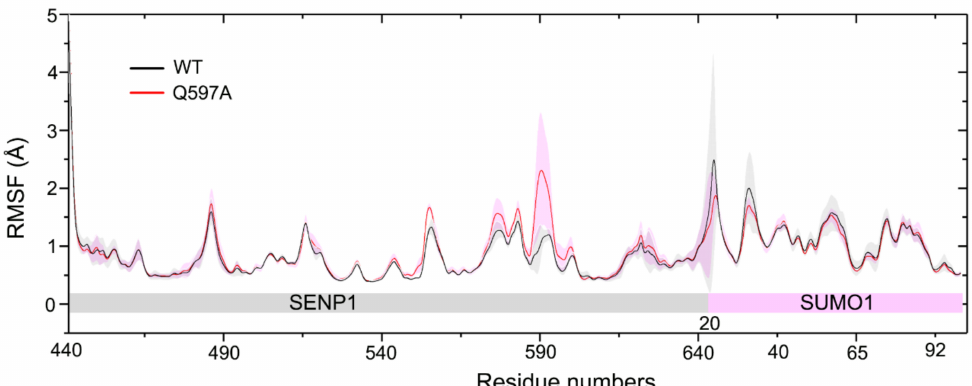
Figure 3. The root-mean-square fluctuation (RMSF) of all C α atoms of the SENP1 − SUMO1 complex for the WT and Q597A mutant systems. Average of three replicates is shown with standard deviation represented transparent shading.